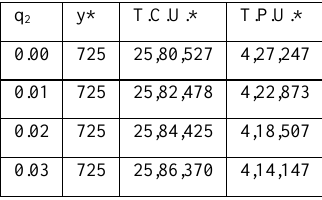
Table 5. Impact of q 2 on optimal production